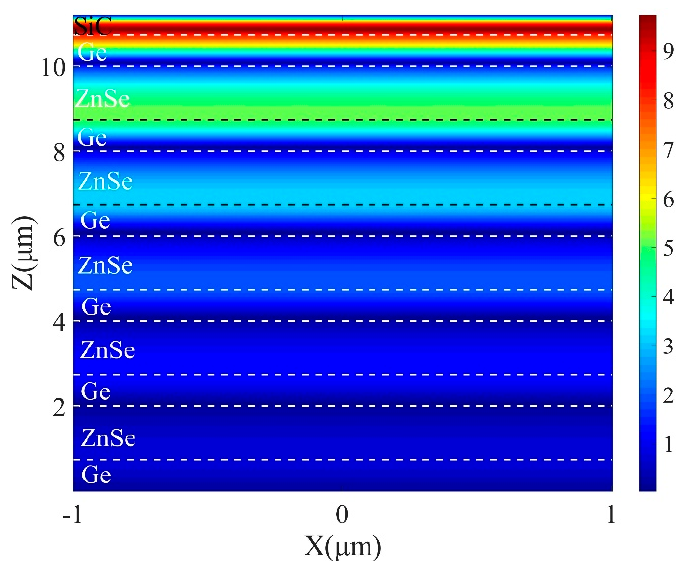
Figure 6. Magnetic field distribution of TM polarization in x − z plane with 5 DBR pairs at λ = 12.8 μ m when t = 0.45 μ m d s = 0.75 μ m, d 1 = 1.25 μ m and d 2 = 0.75 μ m.